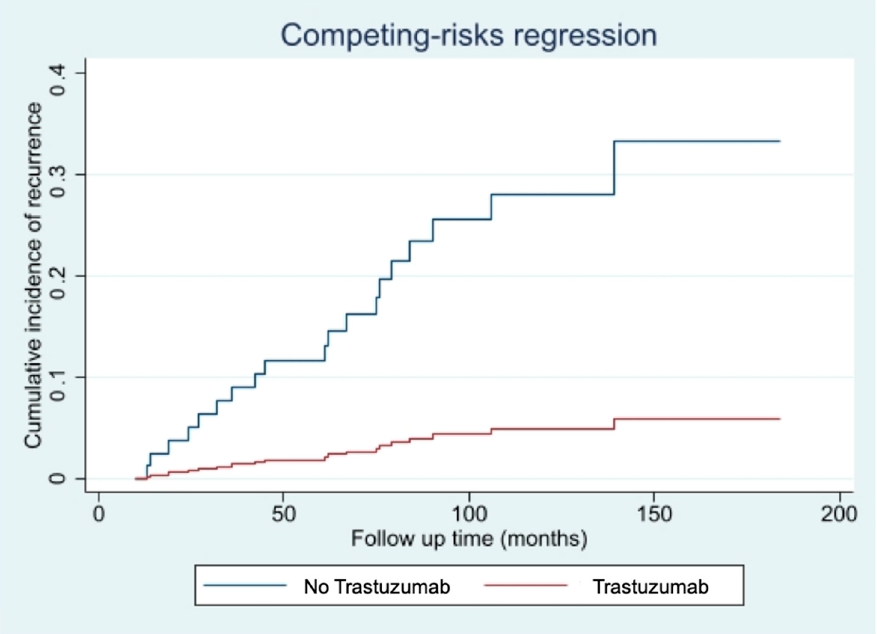
Figure 2. Cumulative incidence of disease recurrence according to treatment with Trastuzumab-Fine-Gray competing risk analysis for intercurrent non-breast cancer-related deaths.